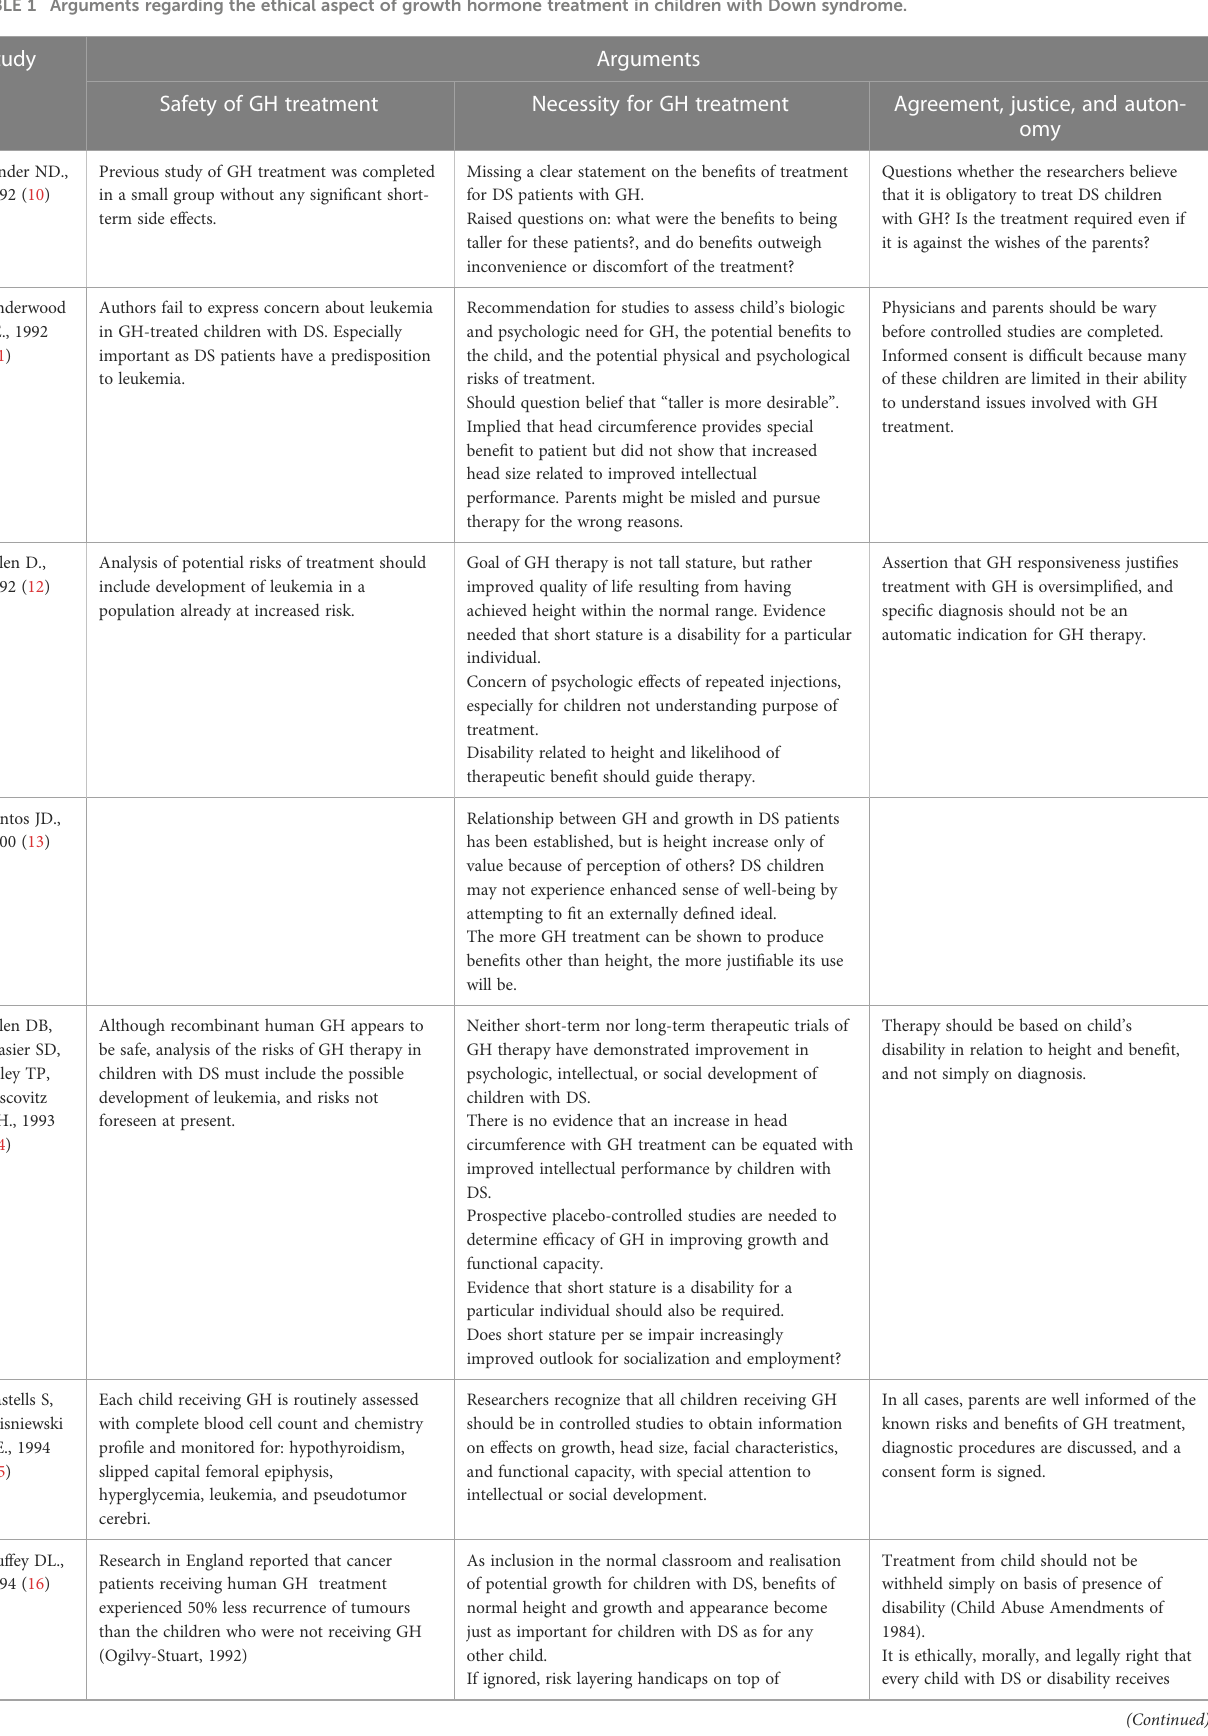
TABLE 1 Arguments regarding the ethical aspect of growth hormone treatment in children with Down